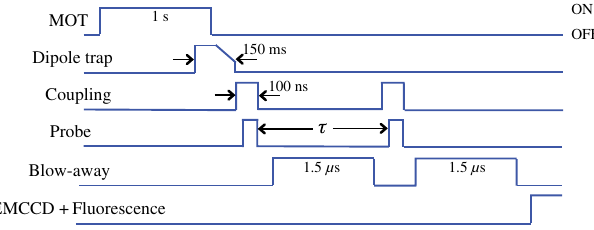
FIG. 5. The timing protocol for the localization experiment. In order to resolve nanometer spatial scales, we use two EIT pulses separated by (cid:3) . The standing wave for the coupling laser is shifted to a different location between the two pulses. This shift is accomplished by setting the frequencies of the two counter- propagating beams to be slightly different. We obtain localiza- tion information through correlation measurements by scanning the spatial shift and recording the number of atoms that remain in the